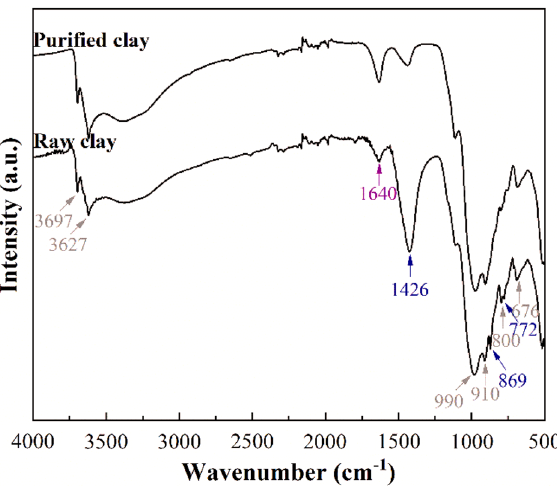
Figure 3. ATR spectra of ray clay and purified clay in the region of 4000–500 cm −1 .